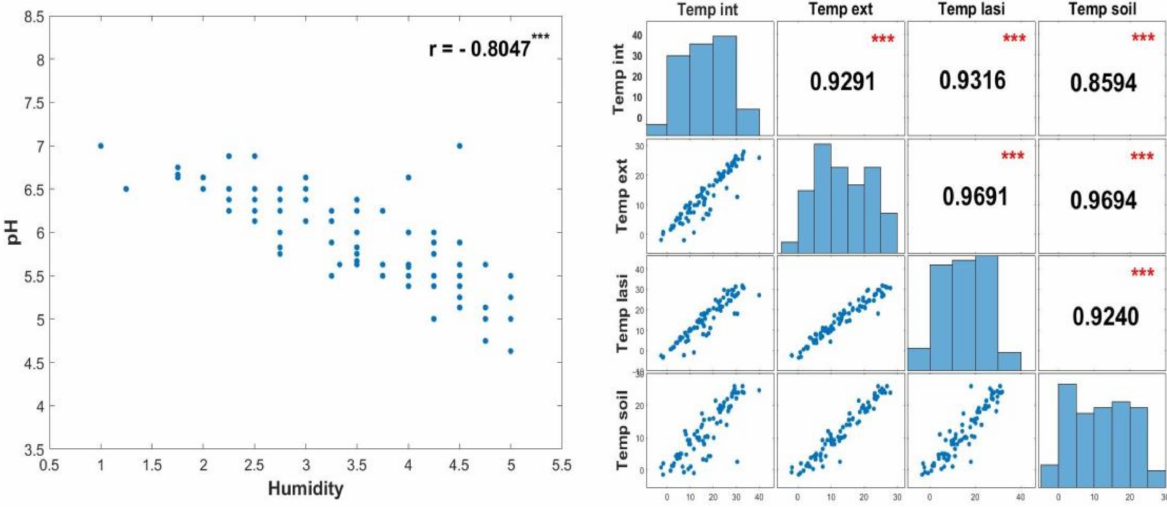
Figure 2. Scatter plot matrix for (left) Humidity vs. pH ; (right) temperatures ( Temp Int , Temp Ext , Temp Iasi , and Temp soil ) (*** p <